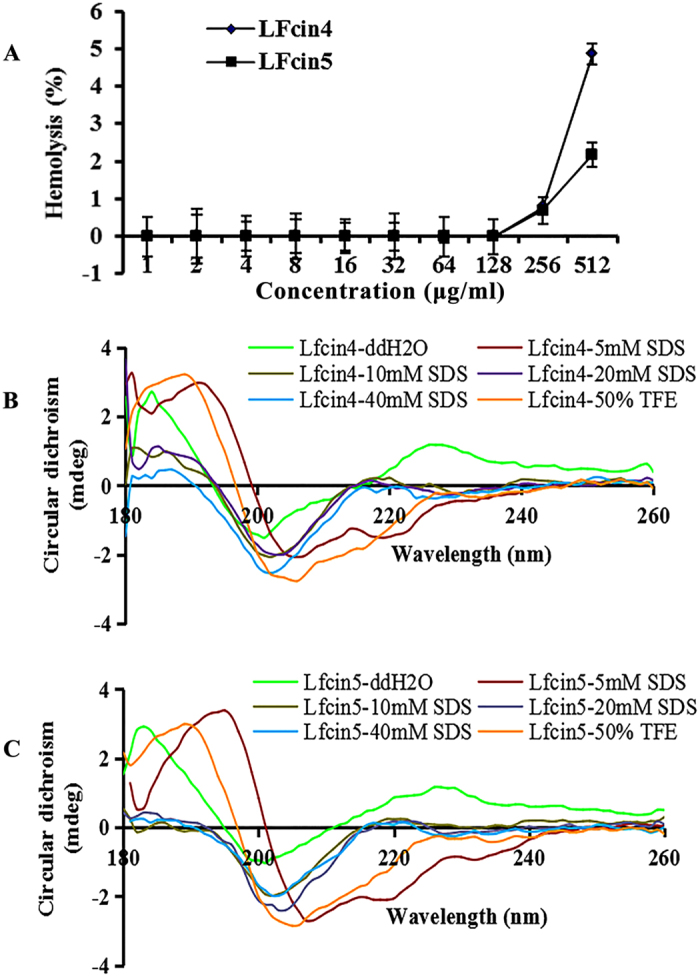
Hemolysis and CD spectra of the secondary structures of Lfcin4 and Lfcin5.(A) Hemolytic activity of Lfcin4 and Lfcin5 against mouse erythrocytes. The results are presented as the mean ± SEM (n = 3). (B,C) CD spectra of the secondary structures of Lfcin4 (B) and Lfcin5 (C).